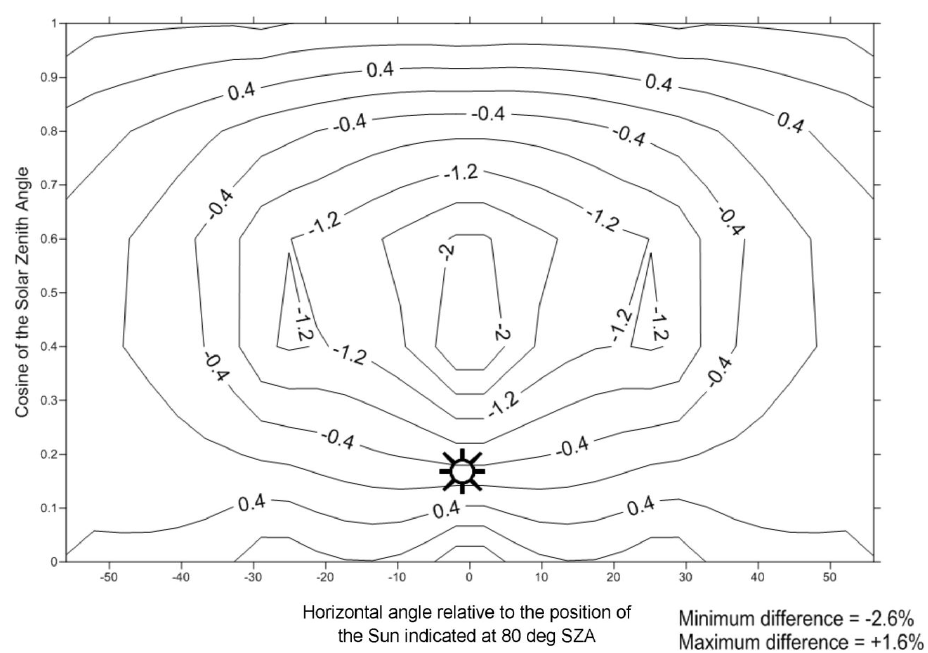
Fig. 11. Percent difference in R/G ratios between the measured at Hydra Sahara dust mineral aerosol profile and a typical modelled volcanic aerosol profile. In both cases AOD (500nm) was set to